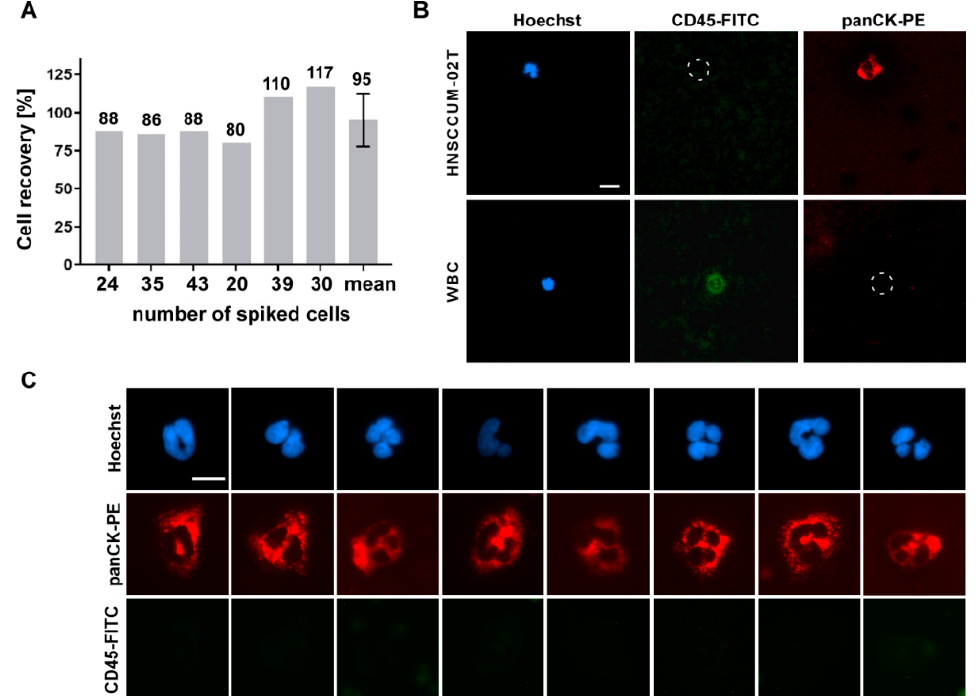
Figure 4. Cell isolation by the IsoMAG System resulted in high recovery rates for head and neck cancer cells. ( A ) Different numbers of HNSCCUM-02T cells were spiked in blood samples and enriched by EpCAM-coupled T1-beads using the IsoMAG unit. ( B ) For cell counting, recovered cells were stained with Hoechst dye, cytokeratin (panCK-PE) and CD45-FITC antibodies and quantified by fluorescence microscopy. [Hoechst+/CD45 − /panCK+) cells were classified as HNSCCUM-02T cells, [Hoechst+/CD45+/panCK − ] cells as leukocytes (WBC). Scale bar, 10 µm. ( C ) Examples of cells enriched by CSV-coupled T1-beads. Cells were stained as described in ( B ). Scale bar, 10 µm.